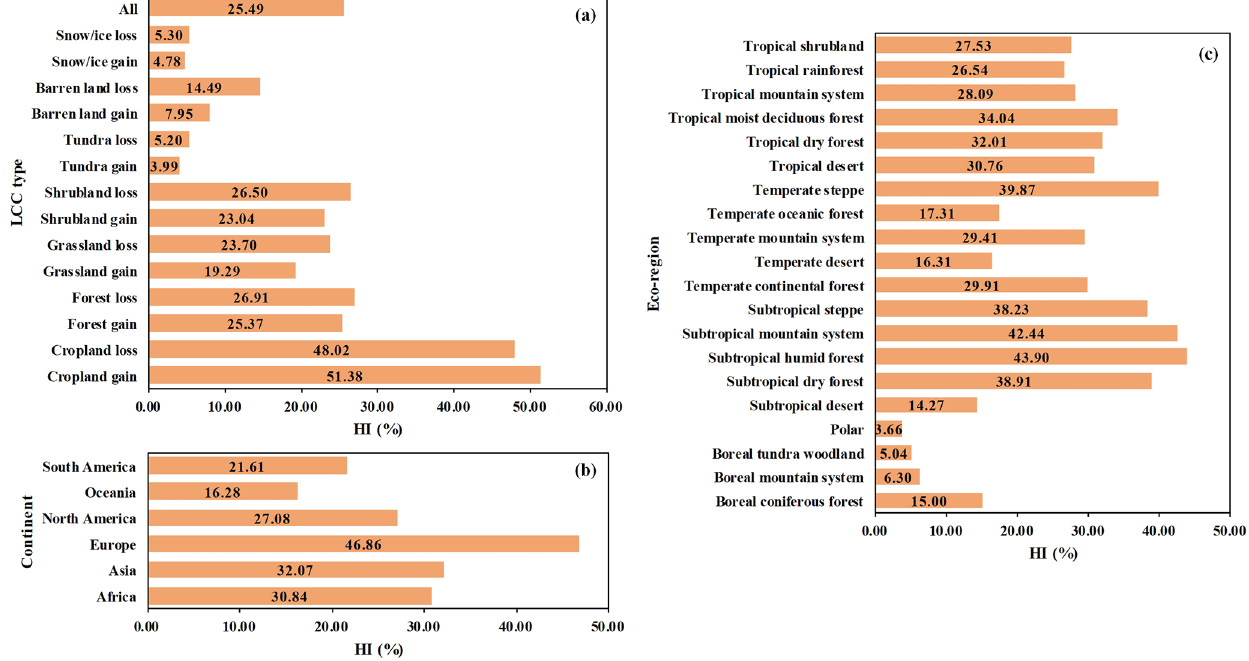
Figure 13. The mean human impact (HI) of regions with significant land cover change on the scale of (a) LCC, (b) continents, and (c) eco-